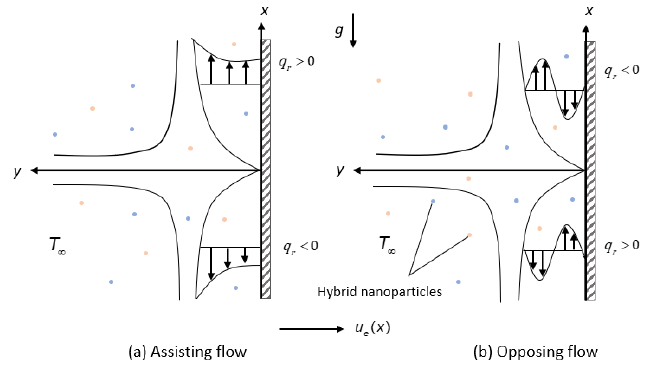
Figure 1. Physical model of the ( a ) assisting flow and ( b ) opposing